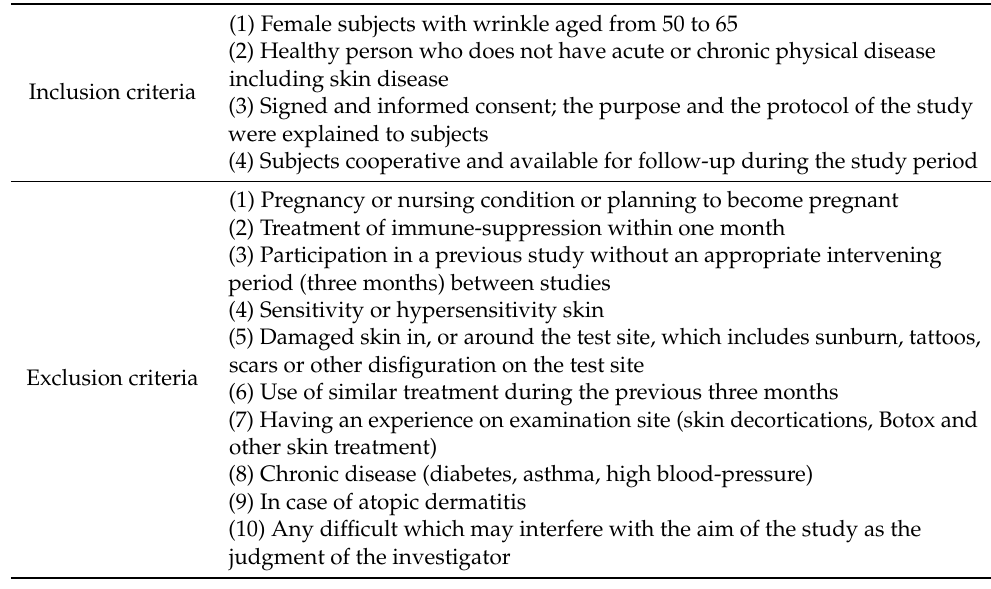
Table 2. The study inclusion and exclusion criteria for clinical